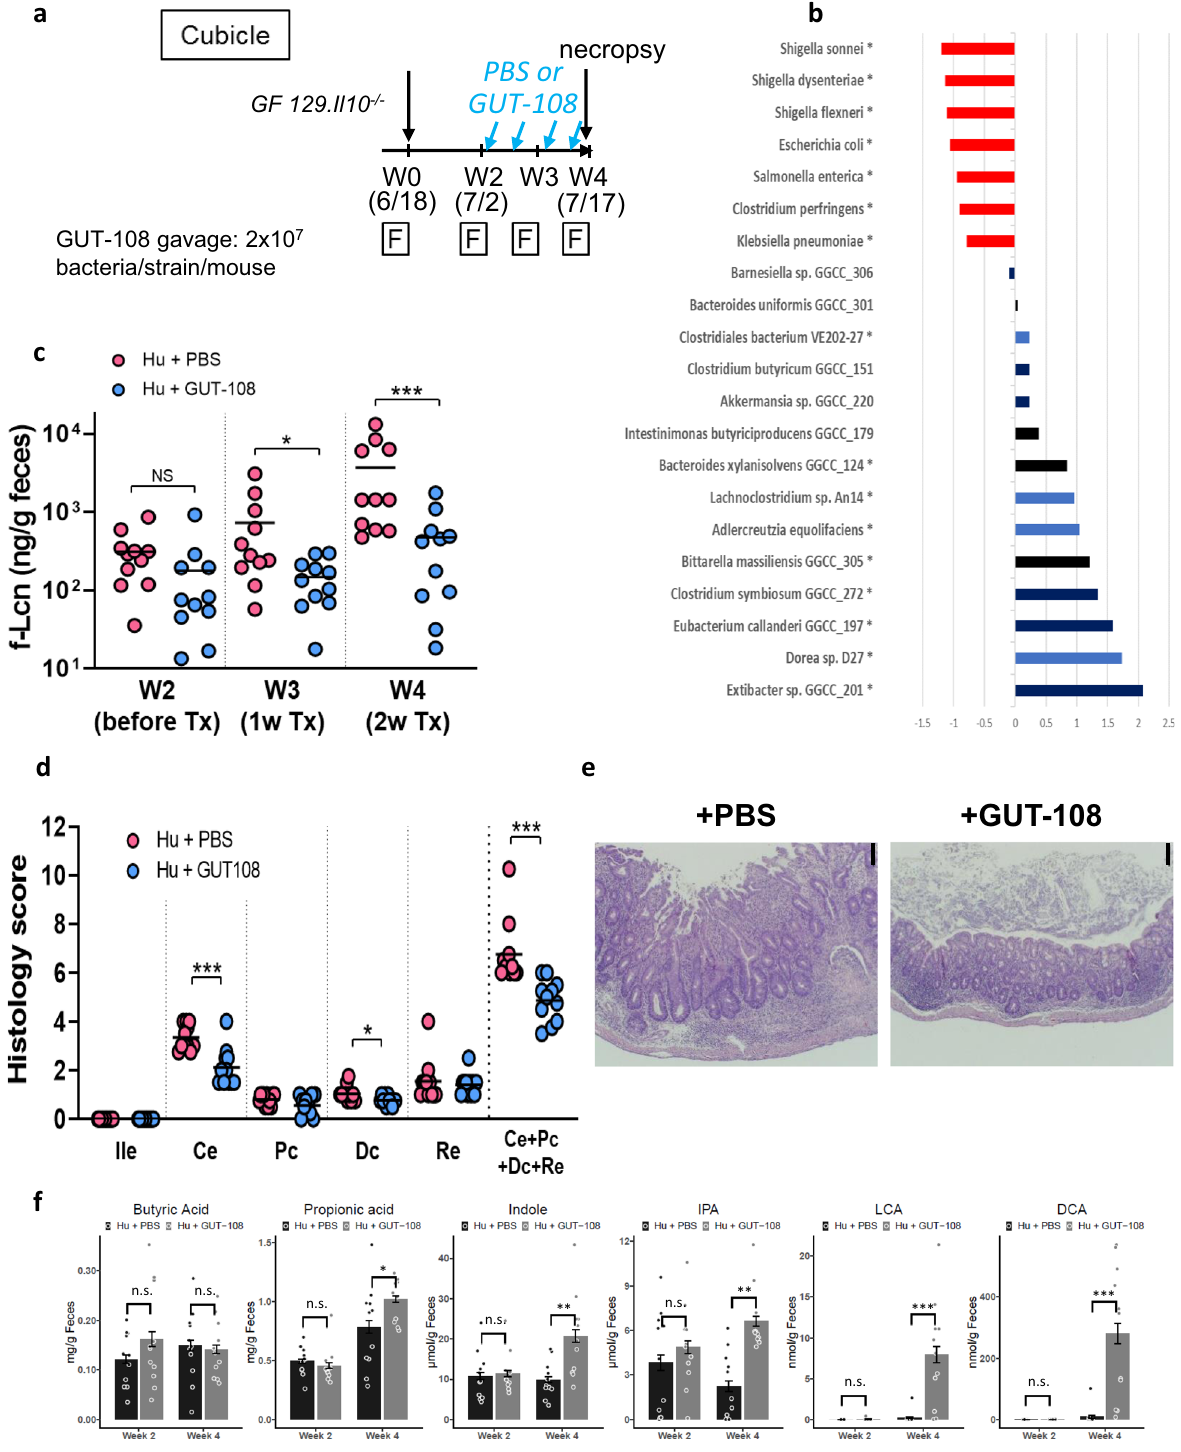
Therapeutic application of GUT-108 reduces in fl ammatory cytokines . Reduced severity of in fl ammation and improved mucosal immune homeostasis after therapeutic application of GUT-108 was characterized by decreased levels of colonic LP effector CD4 + T cells, including Th1 and Th17 cells that produce the in fl ammatory cytokines IFN γ and IL-17 α , respectively, or both IFN γ and IL-17 α (Fig. 5a); reduced distal colonic expression levels of innate and Th1 and Th17 pathway in fl ammatory